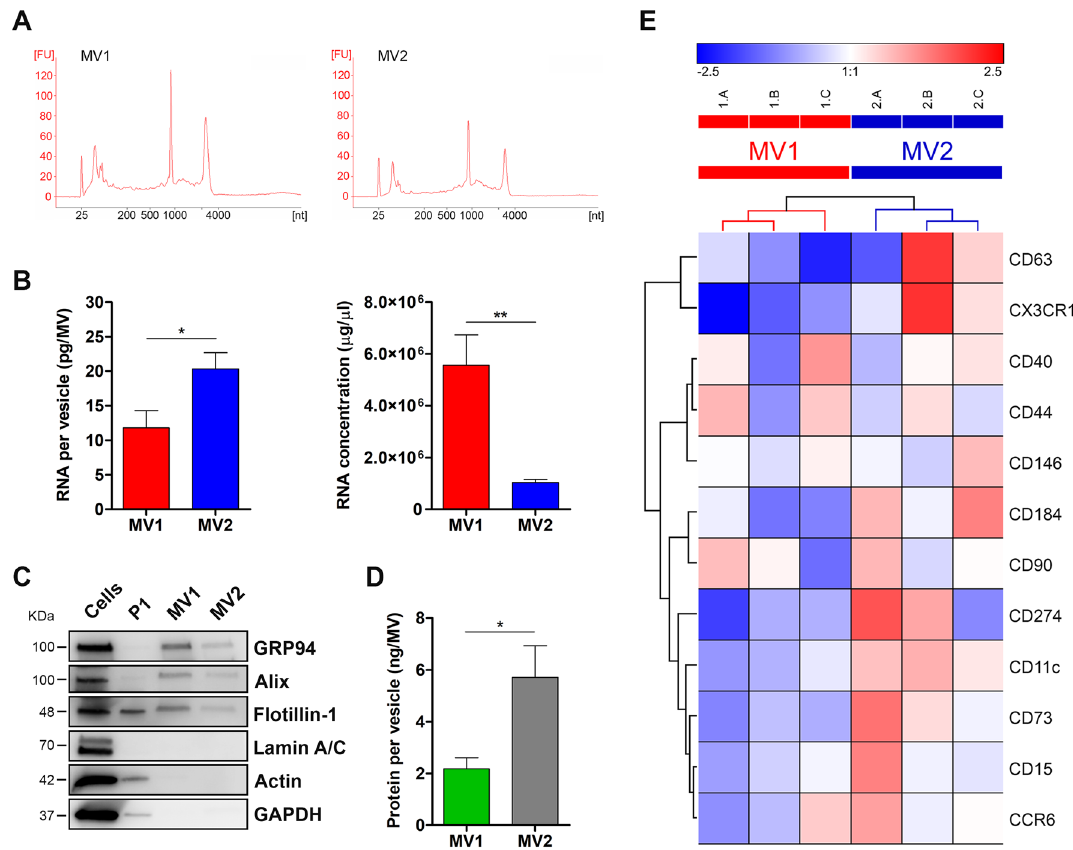
Figure 3. Molecular characterisation of the two MV fractions isolated from microglia cells. ( A ) Representative electropherograms showing profiles of RNA isolated from the two MV fractions analysed by Bioanalyzer (Agilent RNA 6000 Pico Assay; FU: fluorescence units). ( B ) RNA amount (pg/vesicle) and RNA concentration (µg/µl) quantified using Qubit 2.0 Fluorometer and Qubit RNA HS Assay Kit were graphed for each MV fraction. Data are presented as mean ± SEM, *p < 0.05, **p < 0.01, unpaired t-test (GraphPad Prism, version 5). ( C ) Western blot analysis of MV (GRP94, Alix and Flotillin-1), nuclear (Lamin A/C) and cytosolic (Actin and GAPDH) marker contents in MV1 and MV2 fractions and the corresponding CHME-5 cell lysate and P1 fraction. ( D ) Protein amount (ng/vesicle) quantified by micro-BCA assay was reported for each MV fraction. Data are presented as mean ± SEM, *p < 0.05, unpaired t-test (GraphPad Prism, version 5). ( E ) Hierarchical clustering analysis of the immunophenotypic flow cytometry data of MVs recovered in MV1 and MV2 fractions. The expression level of surface markers on MV membranes was measured as MFI ratio. Heatmap was rendered with Genesis 1.8.1 after mean centering and log2 normalization of the expression data. Each row represents a specific surface marker and each column represents individual MVs isolation. Boxes are coloured based on the level of expression of MV surface markers according to the colour scale at the top of the figure. Hierarchical clustering was obtained applying Euclidean distance and UPGMA (Unweighted Pair Group Method using Arithmetic mean) algorithm. Similar results were obtained with different metrics (e.g.: Manhattan distance) and hierarchical clustering algorithms (e.g.: WPGMA; WARD). The dendrogram of the MVs depicts a balanced tree in which the two MVs subpopulation are clearly separated and grouped into two distinct